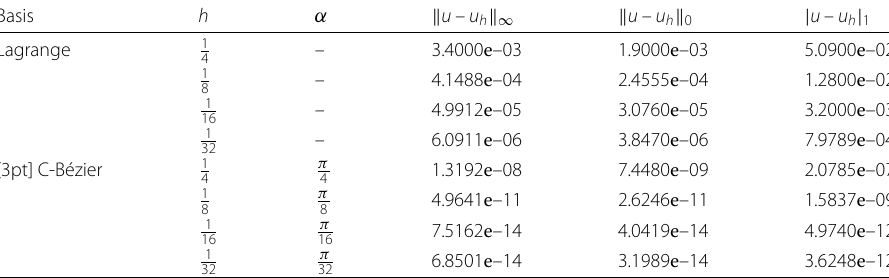
Table 2 The numerical